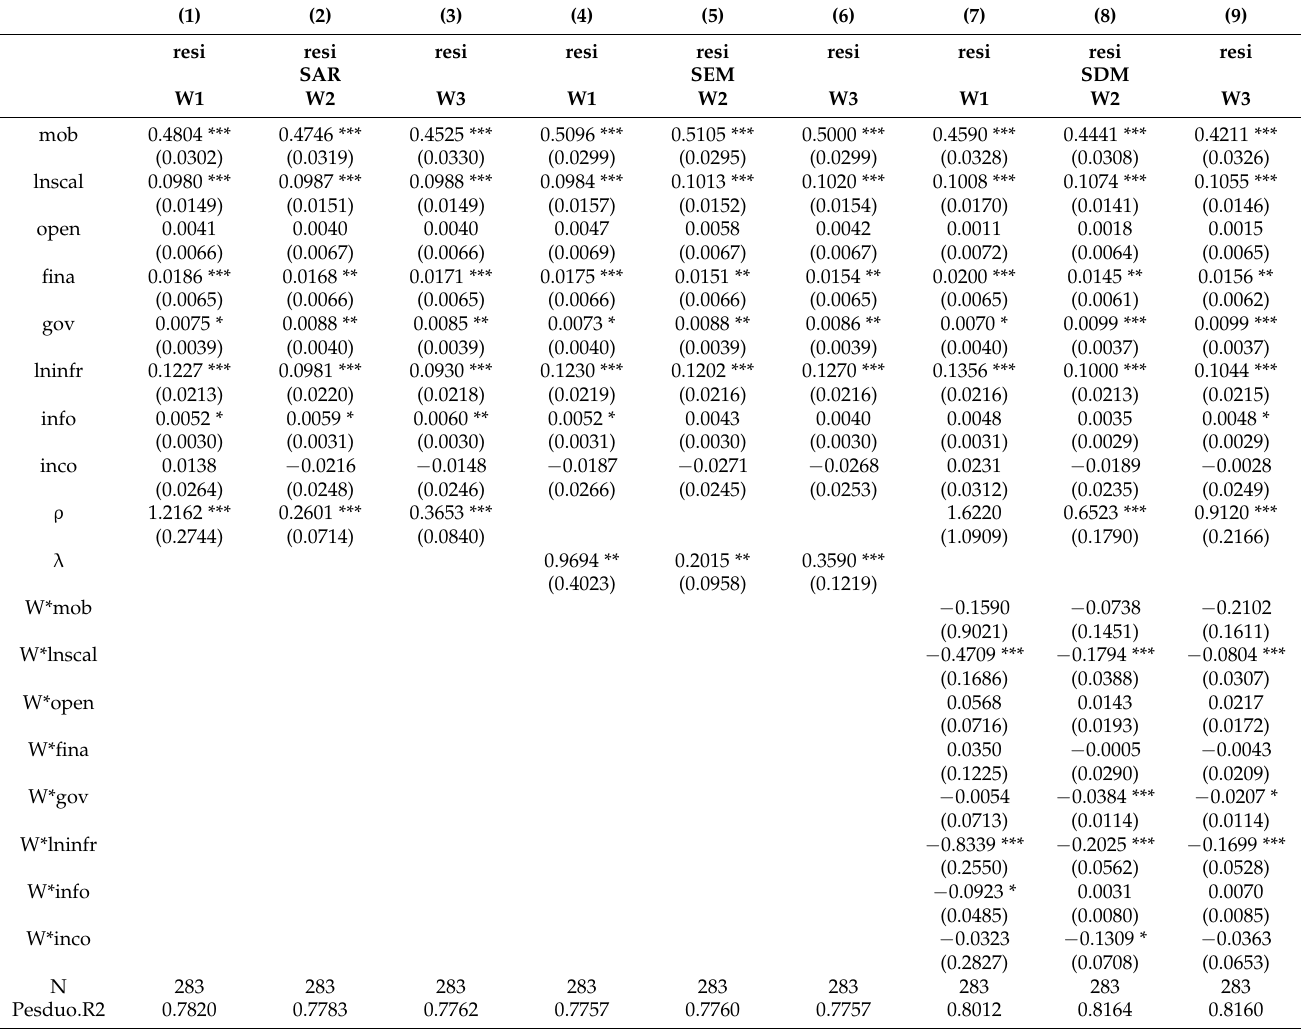
Table 4. Economic resilience and population mobility: baseline